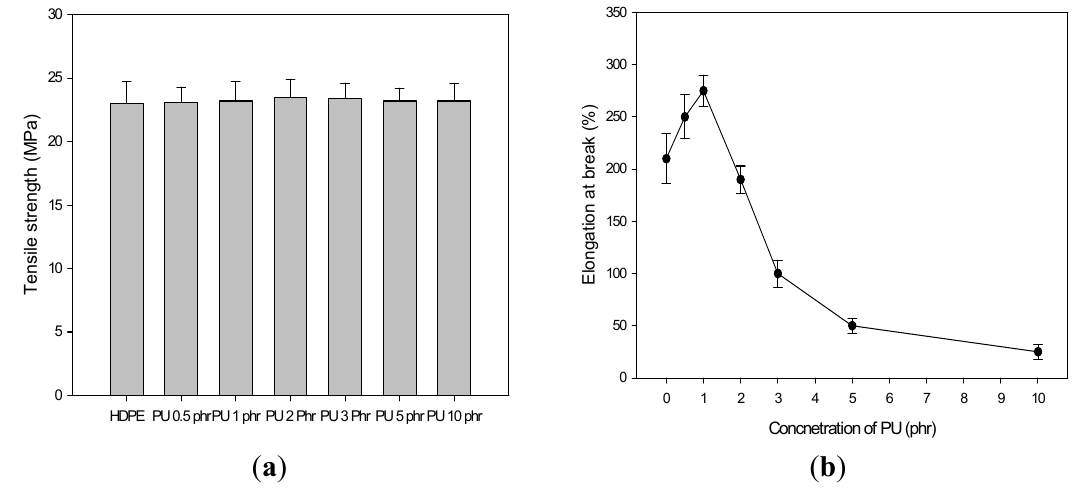
Figure 2. ( a ) Tensile strength and ( b ) elongation at break PU/HDPE composite at various content of PU; absorption dose is 30 kGy.